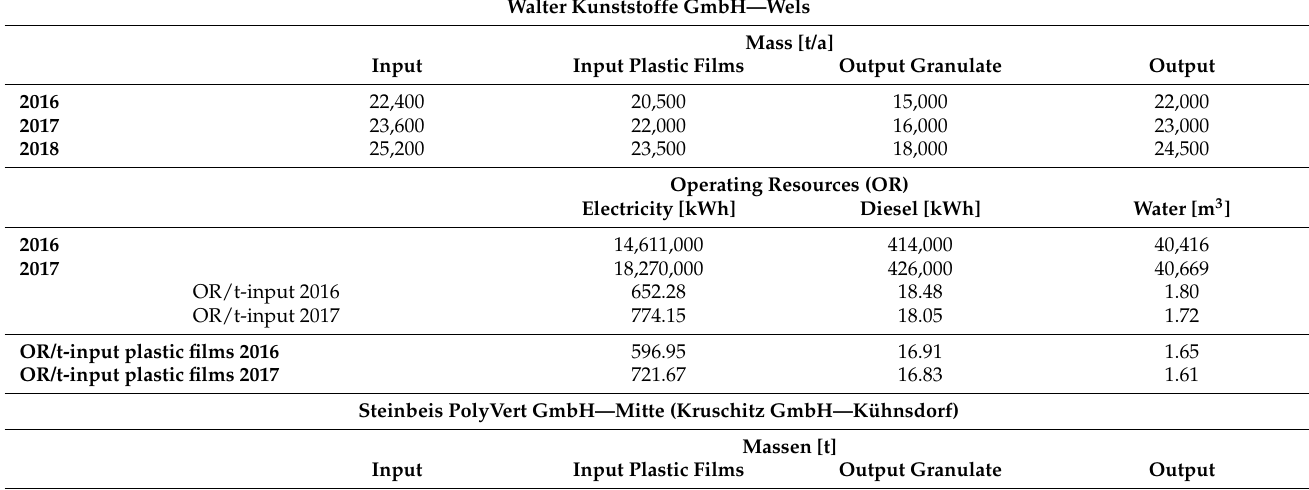
Table A5. Data collection and calculation of the relevant recycling process parameters [5,16,19].